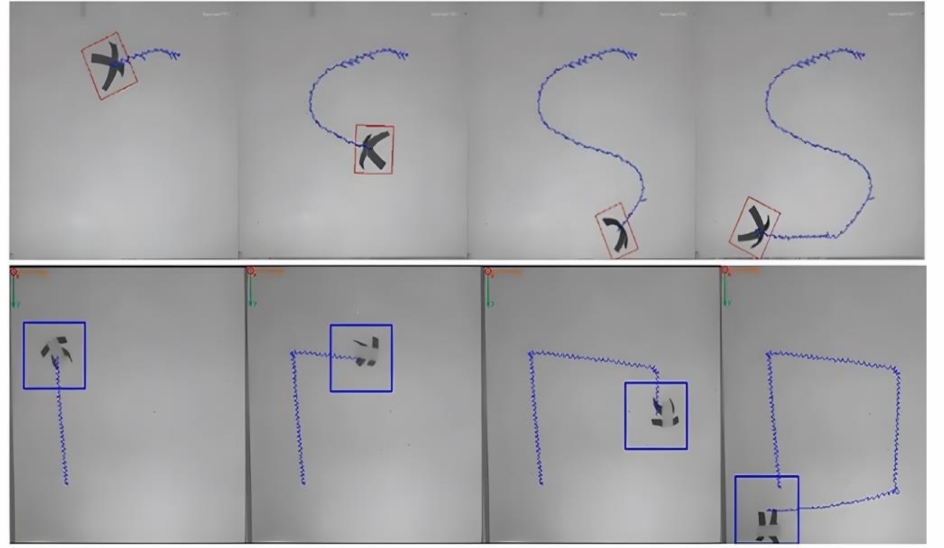
Figure 5. Trajectory of the robot under magnetic field control Adapted with permission from Ref.